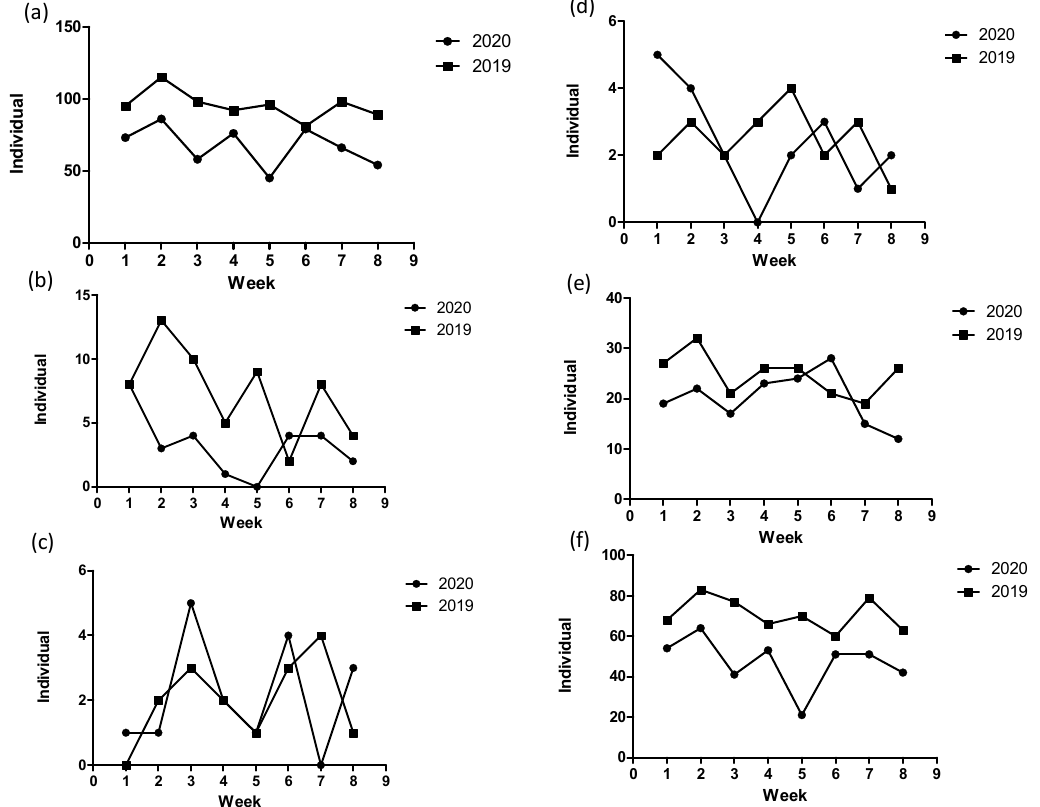
Figure 4. Weekly number of patients receiving the ( a ) total types of surgery, ( b ) total knee arthroplasty, ( c ) total hip arthroplasty, ( d ) hemiarthroplasty, ( e ) emergency surgery, and ( f ) elective surgery at the university hospital during the study (2020) and control (2019) periods.